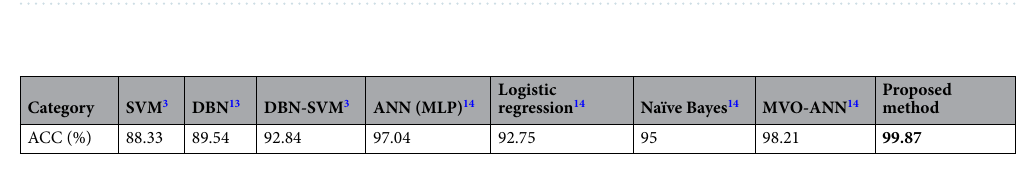
Table 12. Comparison of accuracy with other existing approaches on KDDTrain+ dataset.